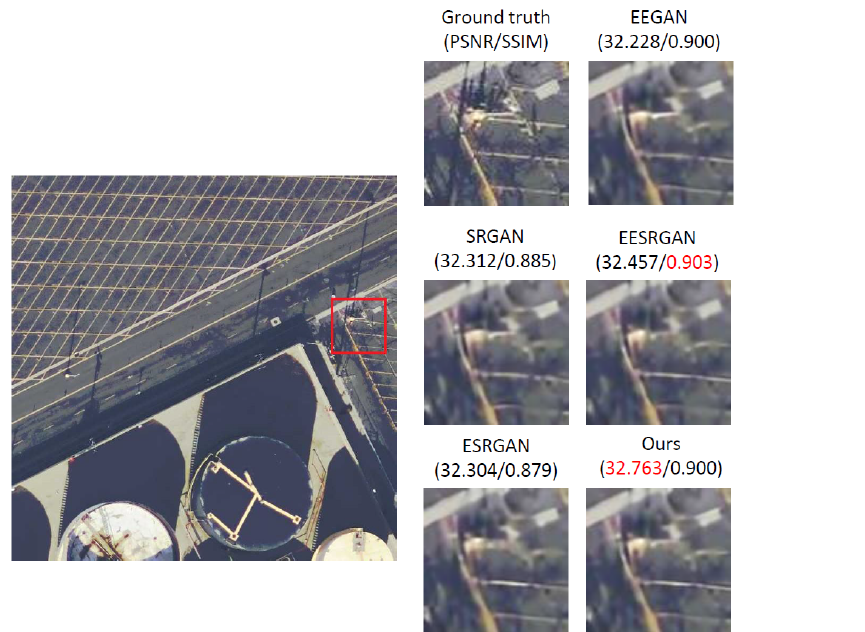
Figure 8. An enlarged partial view of the SR result of each method in the Kaggle dataset, where the best results are shown in red